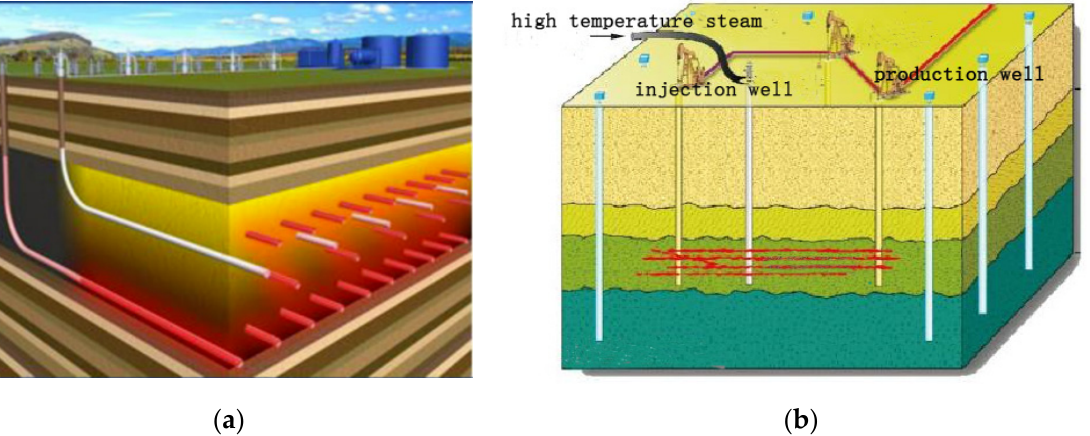
Figure 1. Schematic diagram of in situ heating oil shale technology. ( a ) ICP electric heating technol- ogy [12]; ( b ) Chevron crush technology [13]. (Lonney et al. 2011).